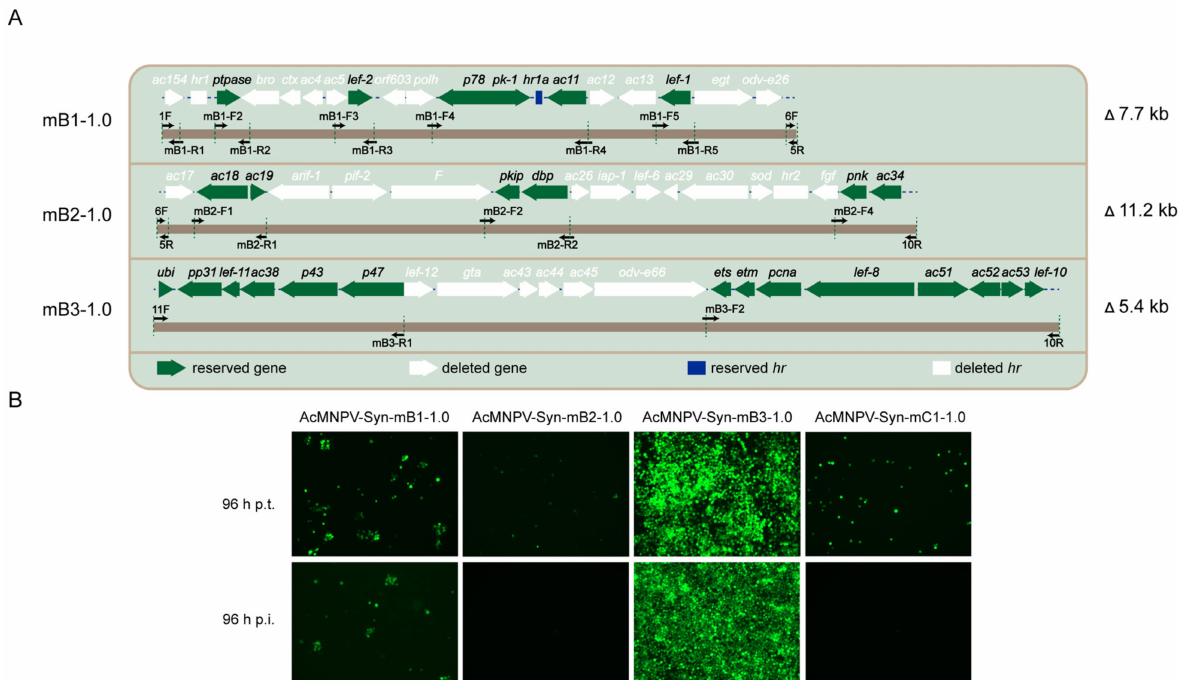
Figure 2. Design and characterization of version 1.0 of the modified genomes. ( A ) Design of mB1-1.0, mB2-1.0, and mB3-1.0. The modified fragments are shown on the backbones of the original B1, B2, and B3. The deleted genes and hr s are coloured white, the reserved genes green, and the reserved hr1a blue. The primers used for overlap extension PCR are indicated. ( B ) Transfection and infection results of AcMNPV-Syn-mB1-1.0, AcMNPV-Syn-mB2-1.0, AcMNPV-Syn-mB3-1.0, and AcMNPV-Syn- mC1-1.0. The images were obtained at 96 h post-transfection (p.t.) and 96 h post-infection (p.i.). The green dots represent infected Sf9